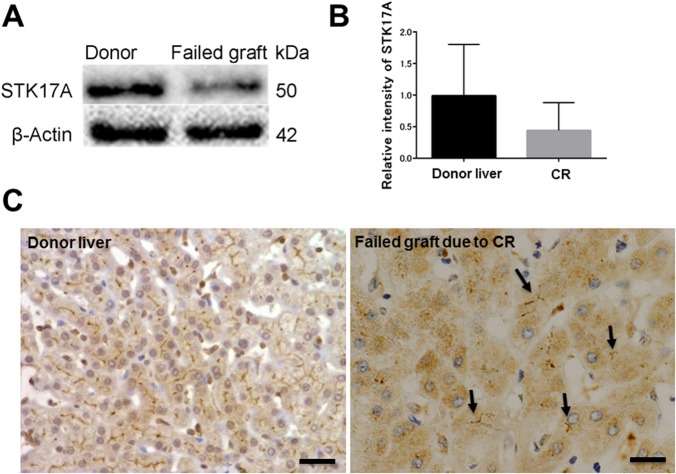
Confirmation of STK17A down-expression in failed allografts due to chronic rejection (CR).(A) Representative Western blot of a healthy donor liver and a failed liver allograft due to CR. This confirms the finding from the antibody microarray analysis that STK17A is downregulated in failed liver allografts due to CR. (B) Relative intensity level of STK17A normalized to that of beta-actin. The means of three independent experiments of normal liver samples and failed allografts due to CR (n = 3, each) were compared. Each bar represents mean ± SEM. (C) Immunohistochemistry for anti-STK17A antibody. Focal bile canalicular staining of failed allograft due to CR in contrast to healthy donor liver, which shows diffuse, linear staining. Arrows represent bile canaliculi. Scale bar: 20 μm.